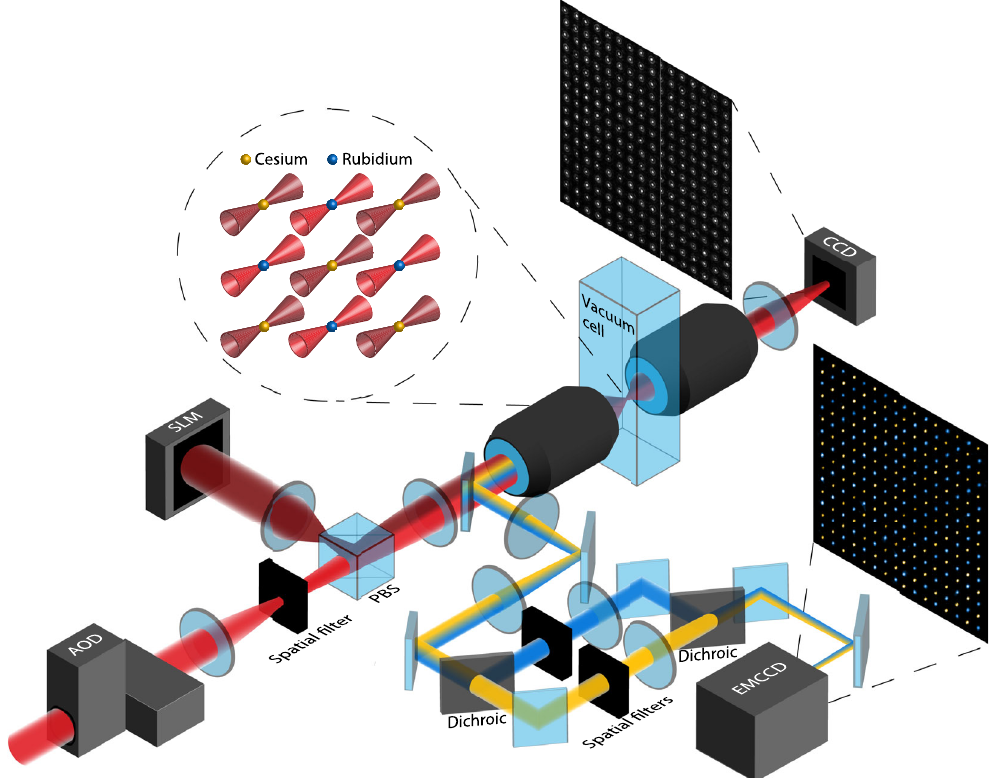
FIG. 1. Trapping and imaging two-dimensional, dual-element arrays of neutral atoms. Optical tweezers are generated using crossed acousto-optic deflectors (AODs) and a spatial light modulator (SLM) at laser wavelengths of 811 nm (red) and 910 nm (dark red), respectively. An optional spatial filter in the AOD path allows us to mask traps selectively and generate desired geometries. The AOD and SLM trapping arrays are then combined via a polarizing beam splitter (PBS). These combined traps propagate along a shared beam path and are focused by a glass-corrected high-numerical-aperture microscope objective with NA ¼ 0 . 65 into a vacuum chamber, thereby creating arbitrary array geometries (shown is a surface-code-inspired geometry with two interleaved arrays). An identical objective images the traps onto a charge-coupled-device (CCD) camera to enable feedback-based intensity homogenization. Atomic fluorescence at 780 nm (blue) for Rb and 852 nm (yellow) for Cs is collected using the first objective and reflected along a shared beam path toward an electron-multiplying CCD (EMCCD) camera using a custom dichroic. The signal to background is improved by separating the fluorescence wavelengths before the EMCCD and performing individual spatial